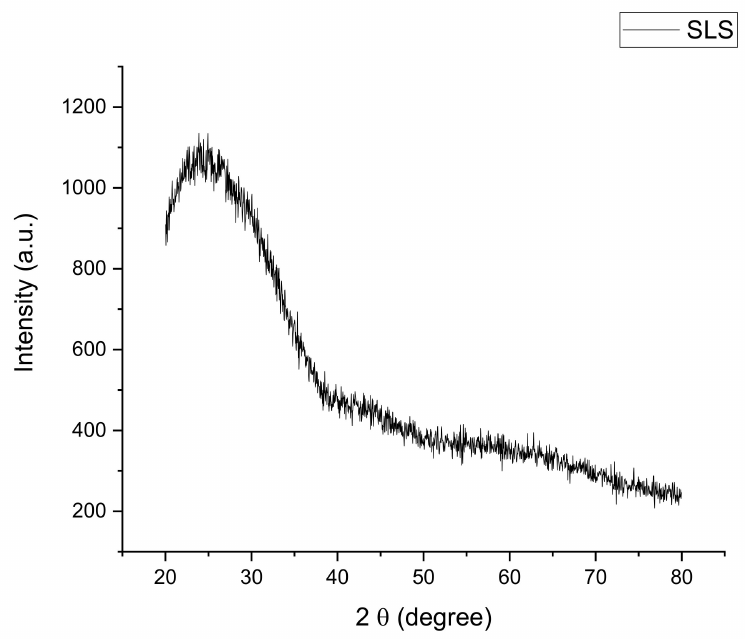
Figure 1. The XRD pattern of waste SLS glass powder at room temperature.